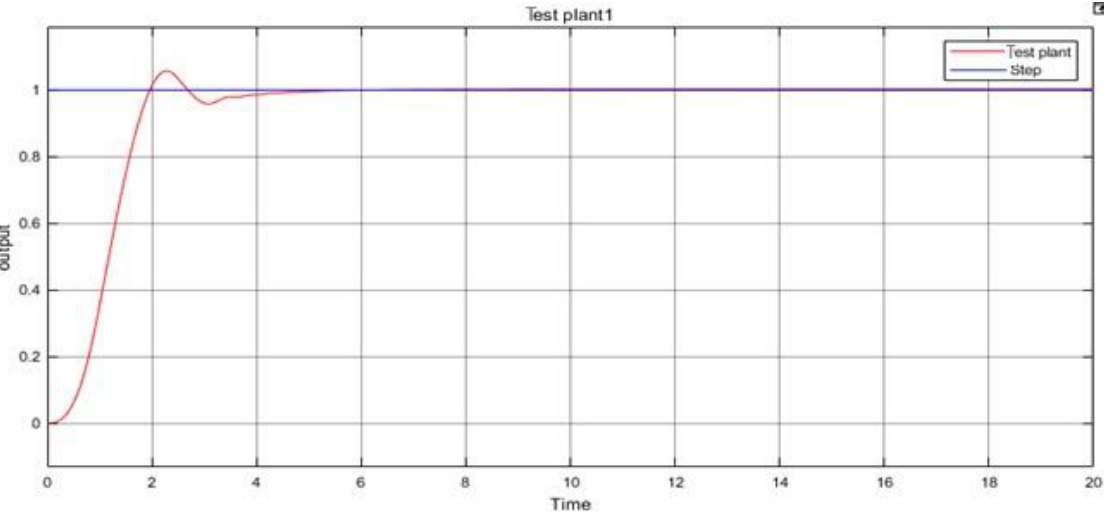
Fig. 6. The response of the system with test plant 1 using GA.